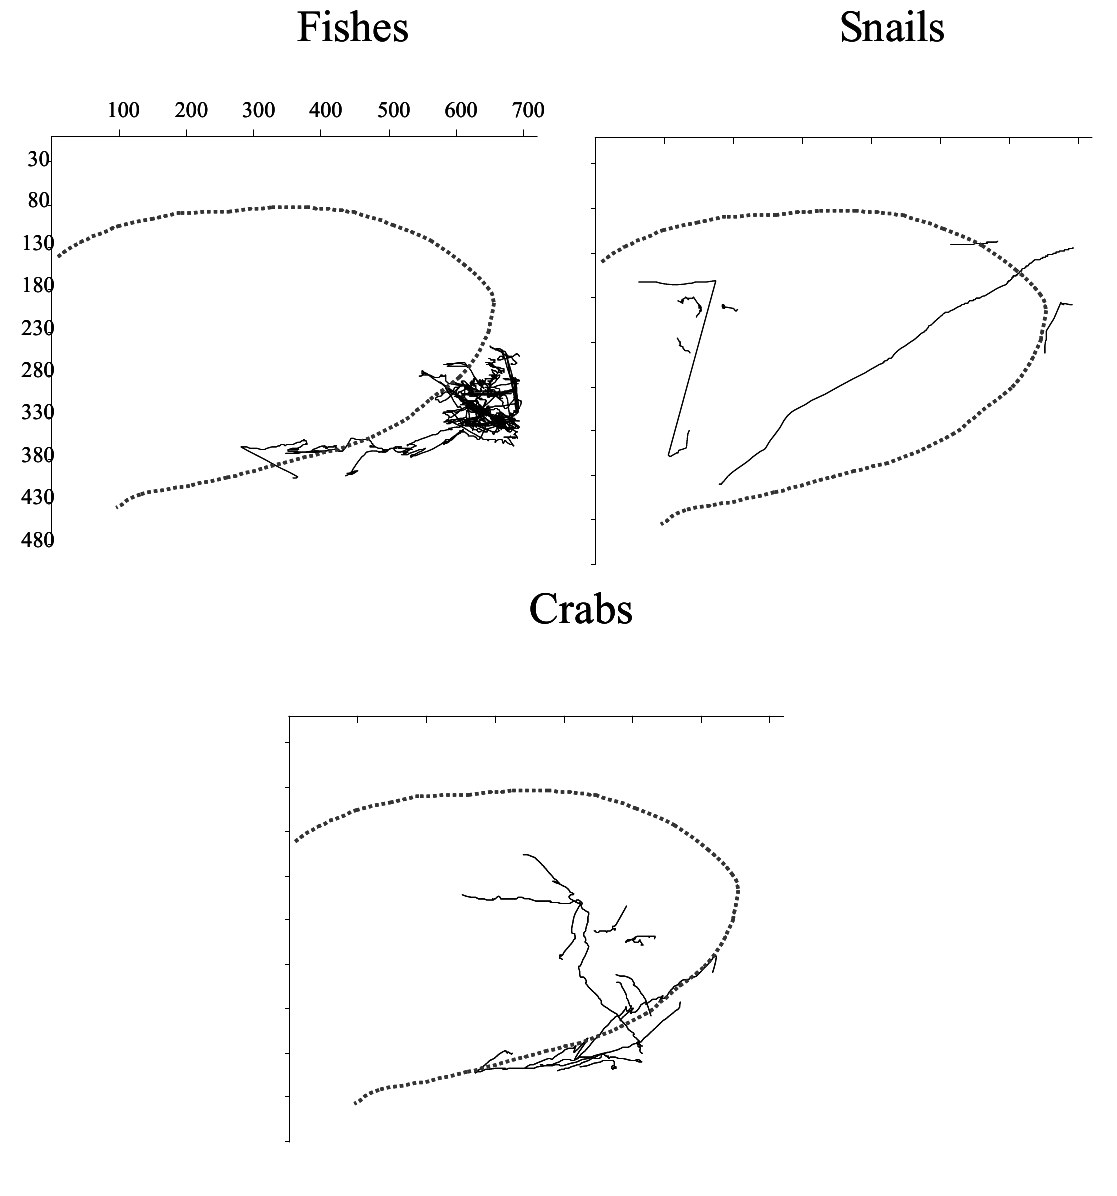
Figure 7. Different trajectories for eelpout fishes, red crabs and snails as detected within the region of interest. The dashed enclosure indicates the bottom area illuminated by video camera